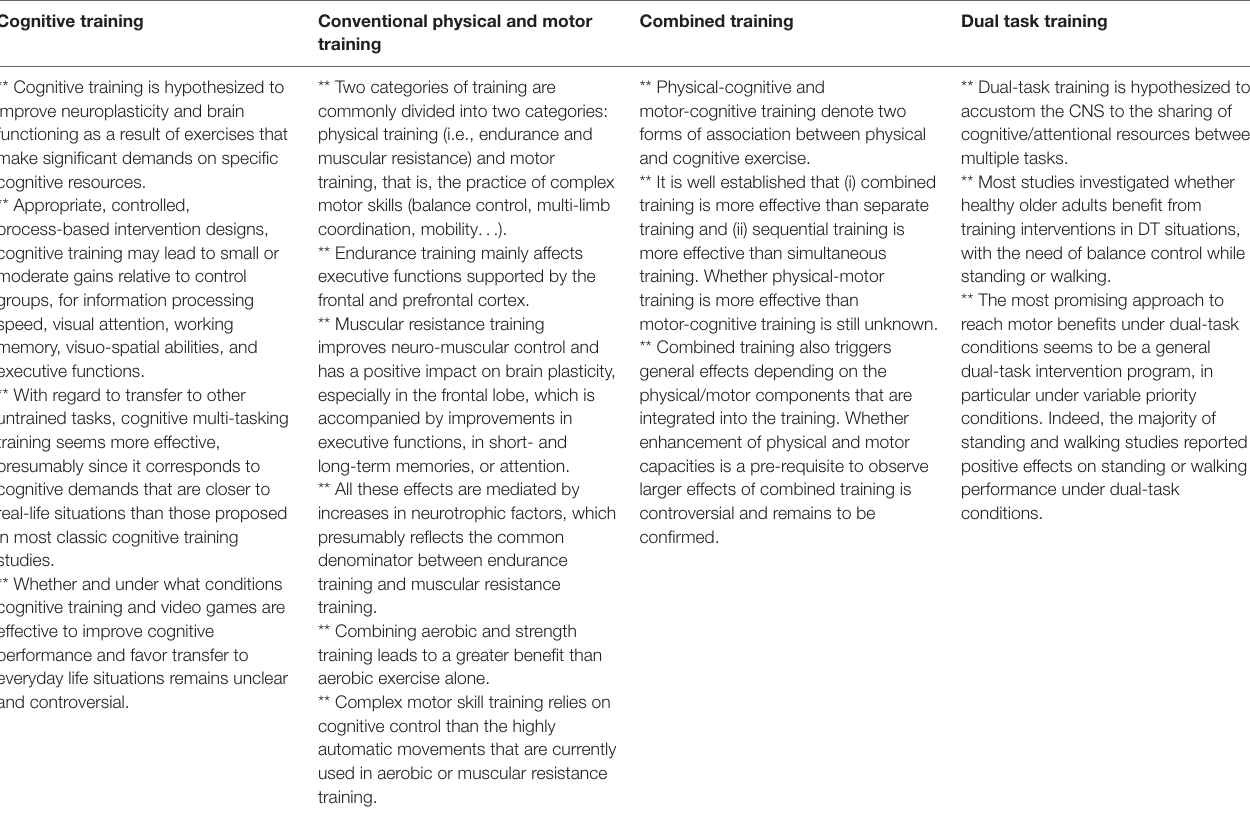
TABLE 1 | Summary table of the main findings of the literature for (i) cognitive training alone, (ii) physical/motor training alone, (iii) combined motor-cognitive and physical-cognitive training, and (iv) simultaneous, dual-task training. Cognitive training Conventional physical and motor Combined training Dual task training